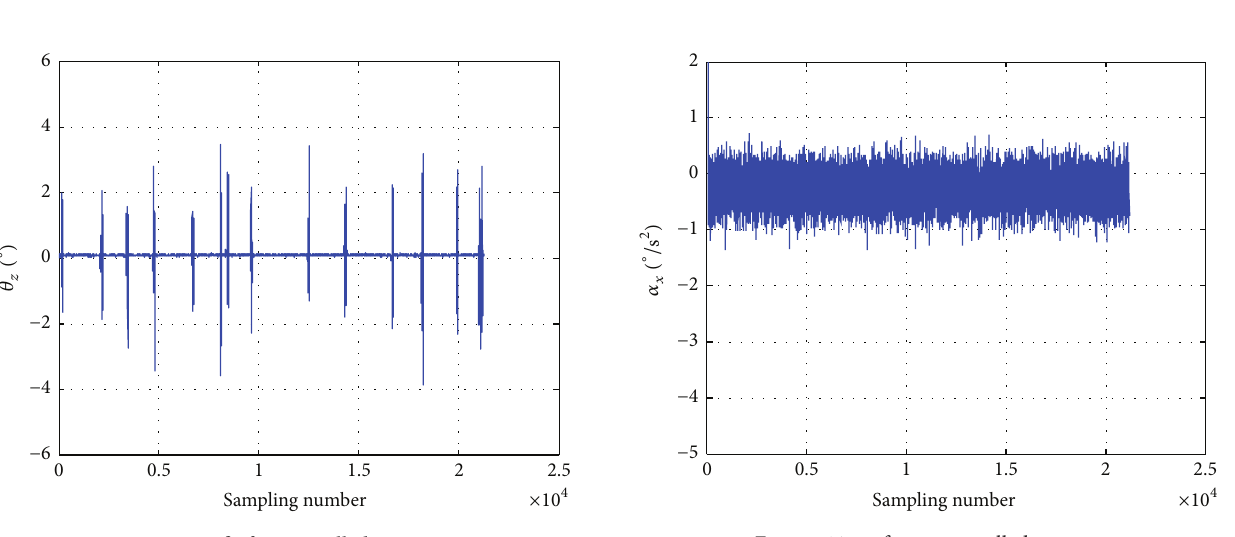
Figure 11: 𝜃 𝑧 for controlled system.